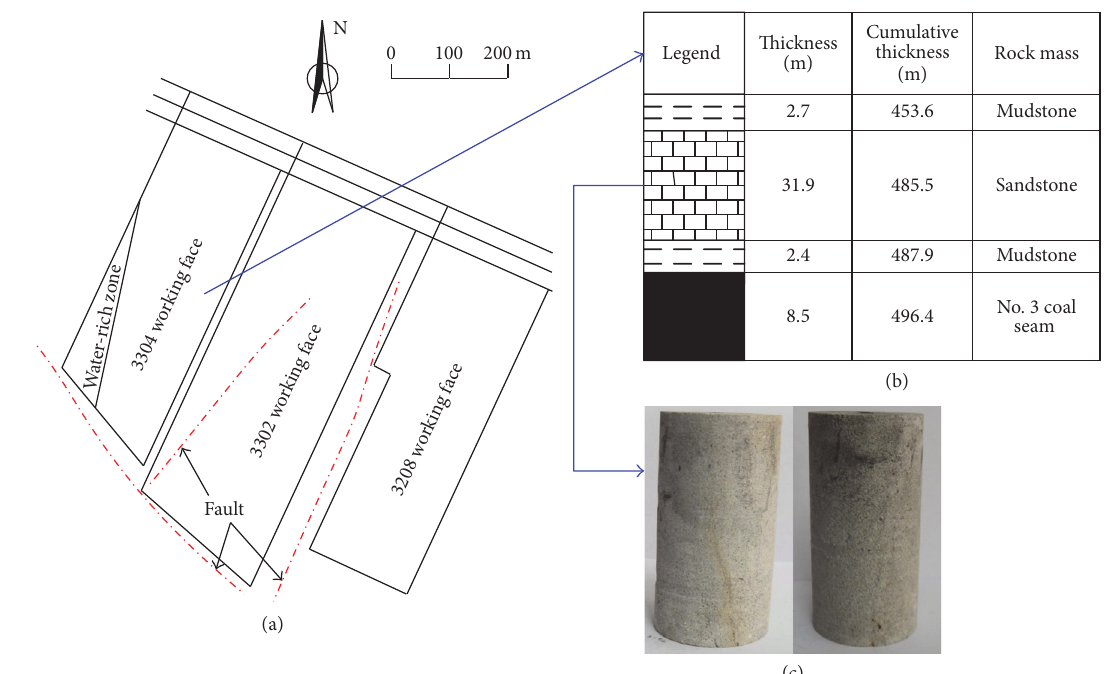
Figure 1: Geological conditions: (a) layout of working faces, (b) borehole column, and (c) sandstone